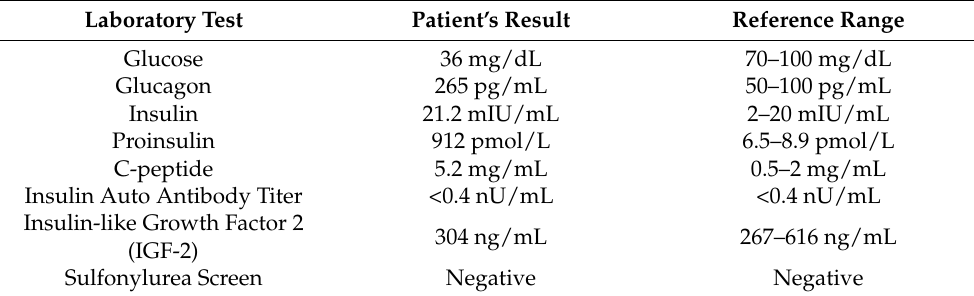
Table 1. Laboratory Evaluation at 12 Hours